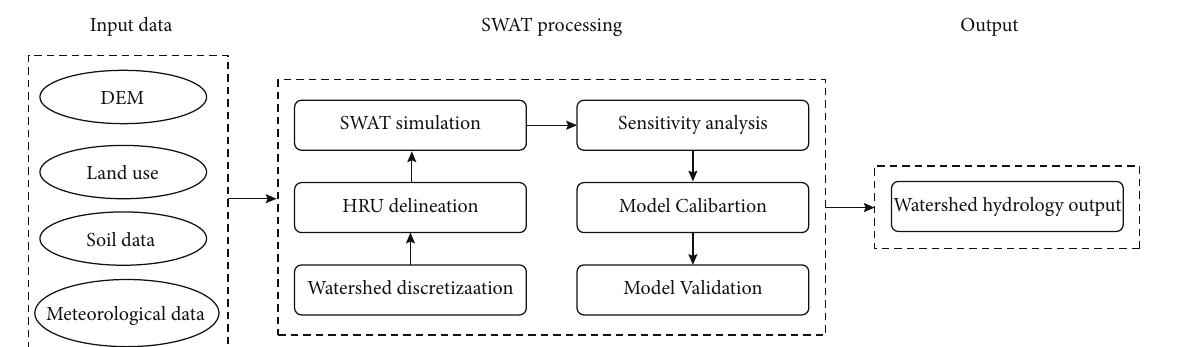
Figure 4: General framework methodology of the model.